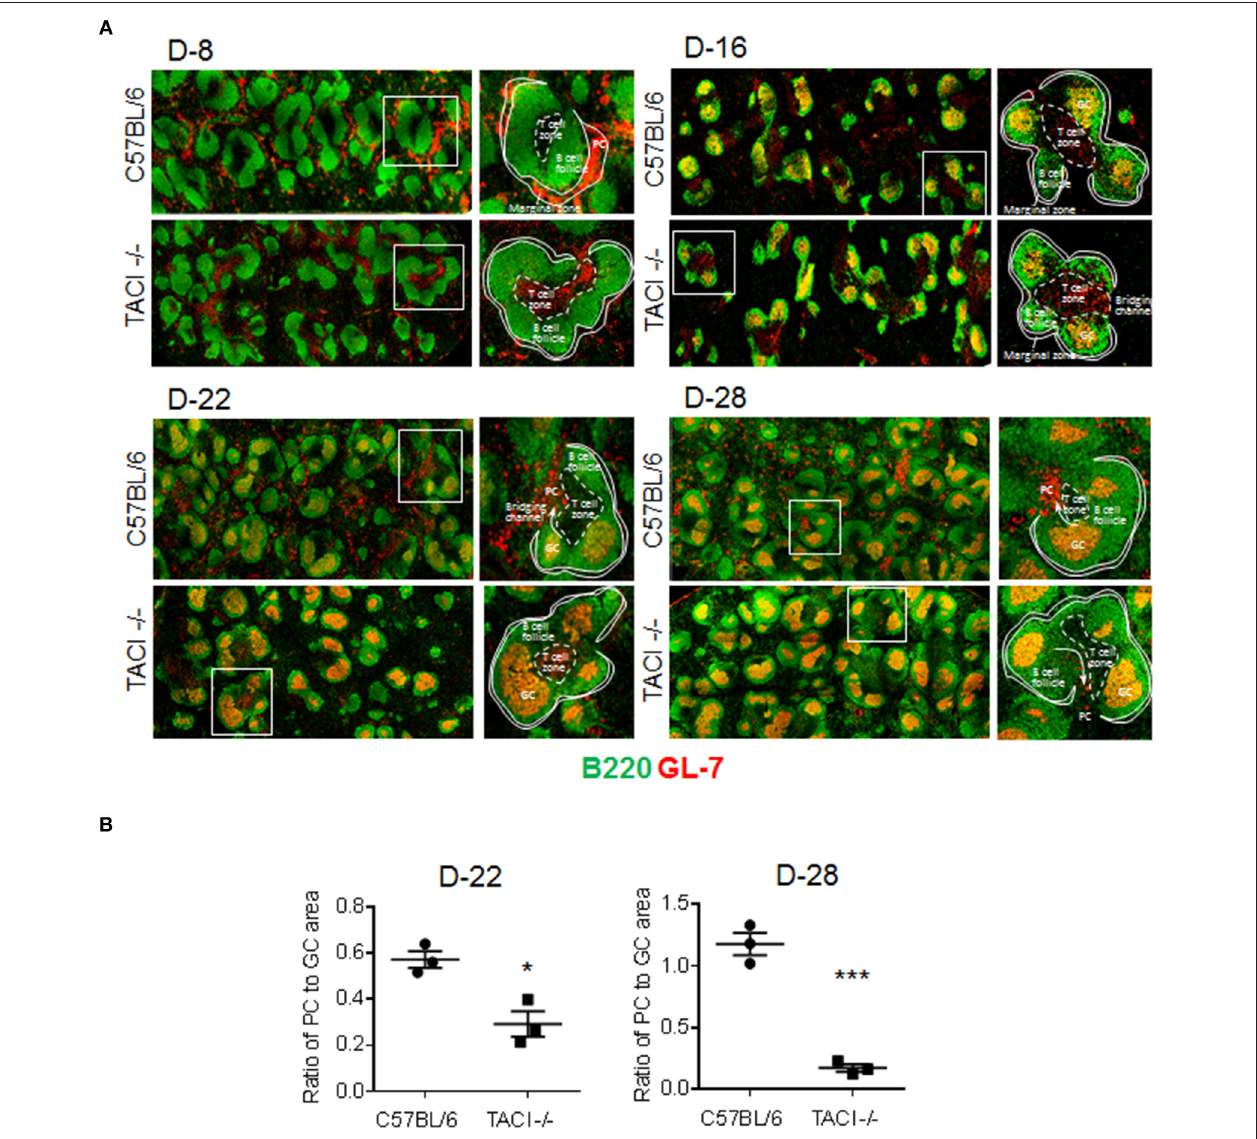
FIGURE 3 | PC output from GC is limited in TACI -/- mice. TACI -/- and C57BL/6 mice were infected (i.p.) with 1 × 10 6 P. yoelii (Py 17XNL) parasites. Splenic GC and PC were examined by microscopy on indicated days after infection. (A) Histologic sections of spleens were stained with anti-B220 (green) and anti-GL-7 (red) antibodies to visualize B-cell follicles (green), GC (B220 + GL-7 + , yellow), and PC (B220 low GL-7 + , orange). T-cell independent PC are located in the marginal zone and T-cell dependent PC in red pulp of the spleen, adjacent to the “Bridging channels.” T cell zones were defined as central location where tightly packed follicles are distributed around and the activated T cells (B220 − GL-7 + , red) are located. Arrows indicate the plasmablast pathway to extrafollicular areas through the “Bridging channels.” (B) PC output was calculated by ratio of PC foci to GCs in half spleen. Each dot represents one mouse. Magnification is 10x. * p < 0.05 and *** p < 0.001 for TACI -/- vs. C57BL/6 comparison. Experiment was performed